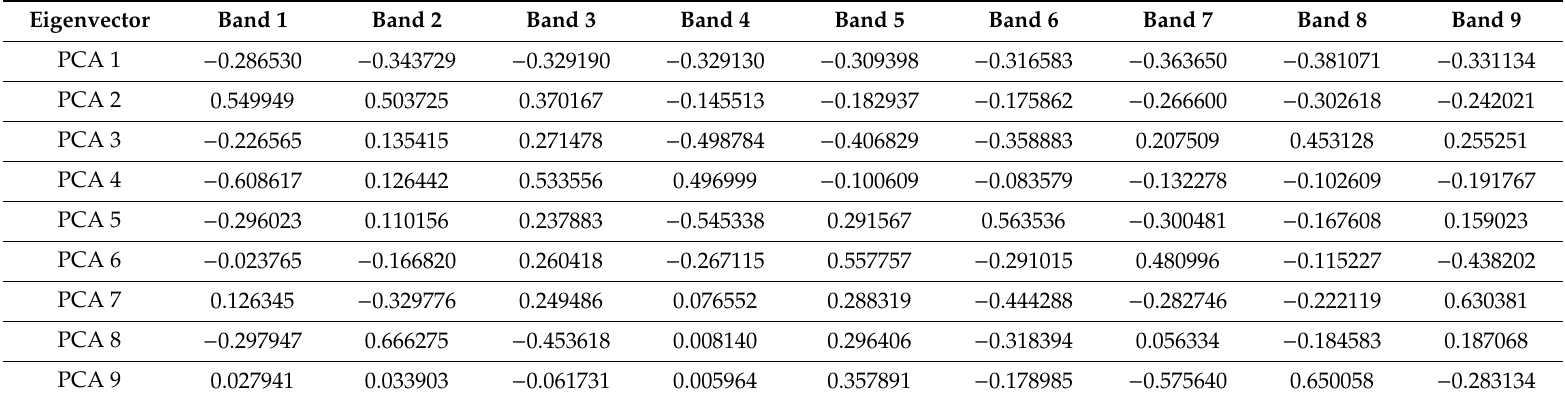
Table 3. Eigenvector matrix for Advanced Space-borne Thermal Emission and Reflection Radiometer (ASTER) visible near infrared region (VNIR) + short wave infrared region (SWIR) principal component analysis (PCA) images.